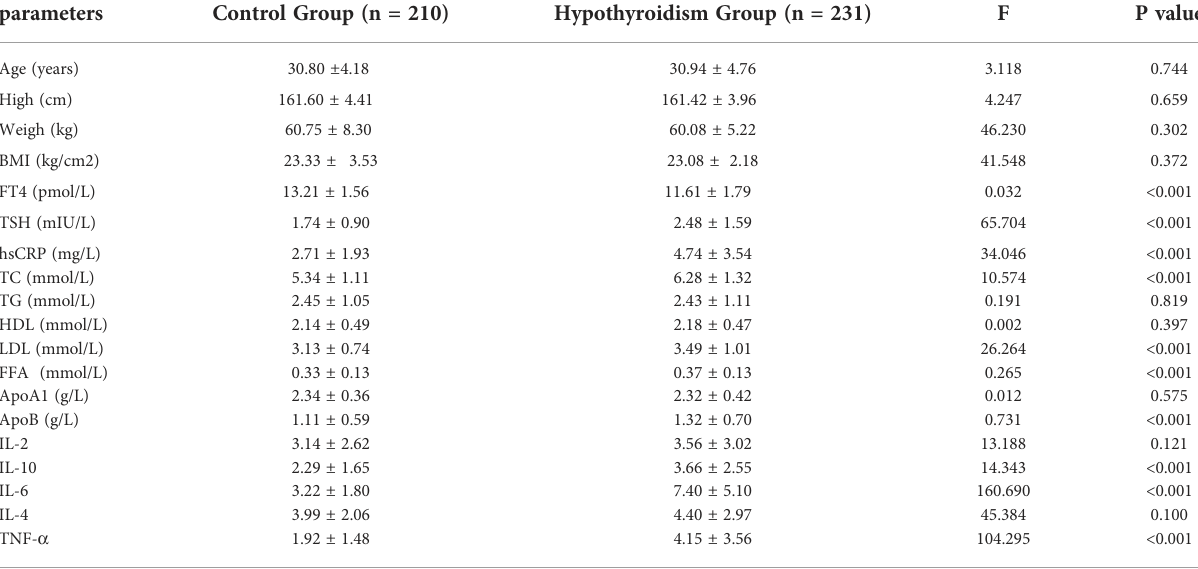
TABLE 3 Comparison of general data between pregnant women with clinical hypothyroidism during pregnancy and pregnant women in the control group.